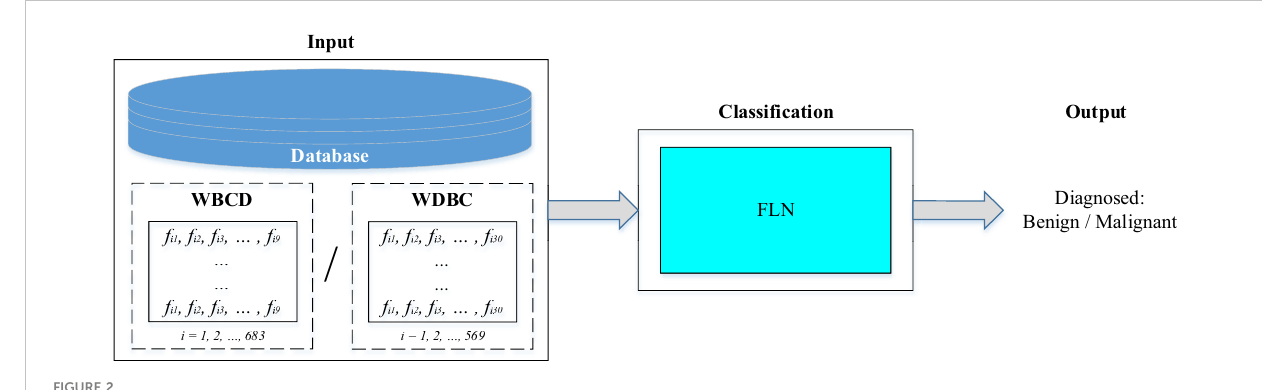
FIGURE 2 Diagram of the proposed breast cancer diagnosis classi fi er.